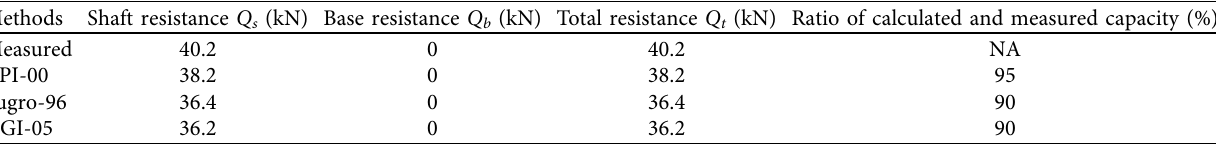
Figure 6: Load transfer behavior and shaft resistance distribution with depth during ultimate tension bearing calculated by different design methods. Table 2: Comparison of measured and calculated results of tension capacity with different design